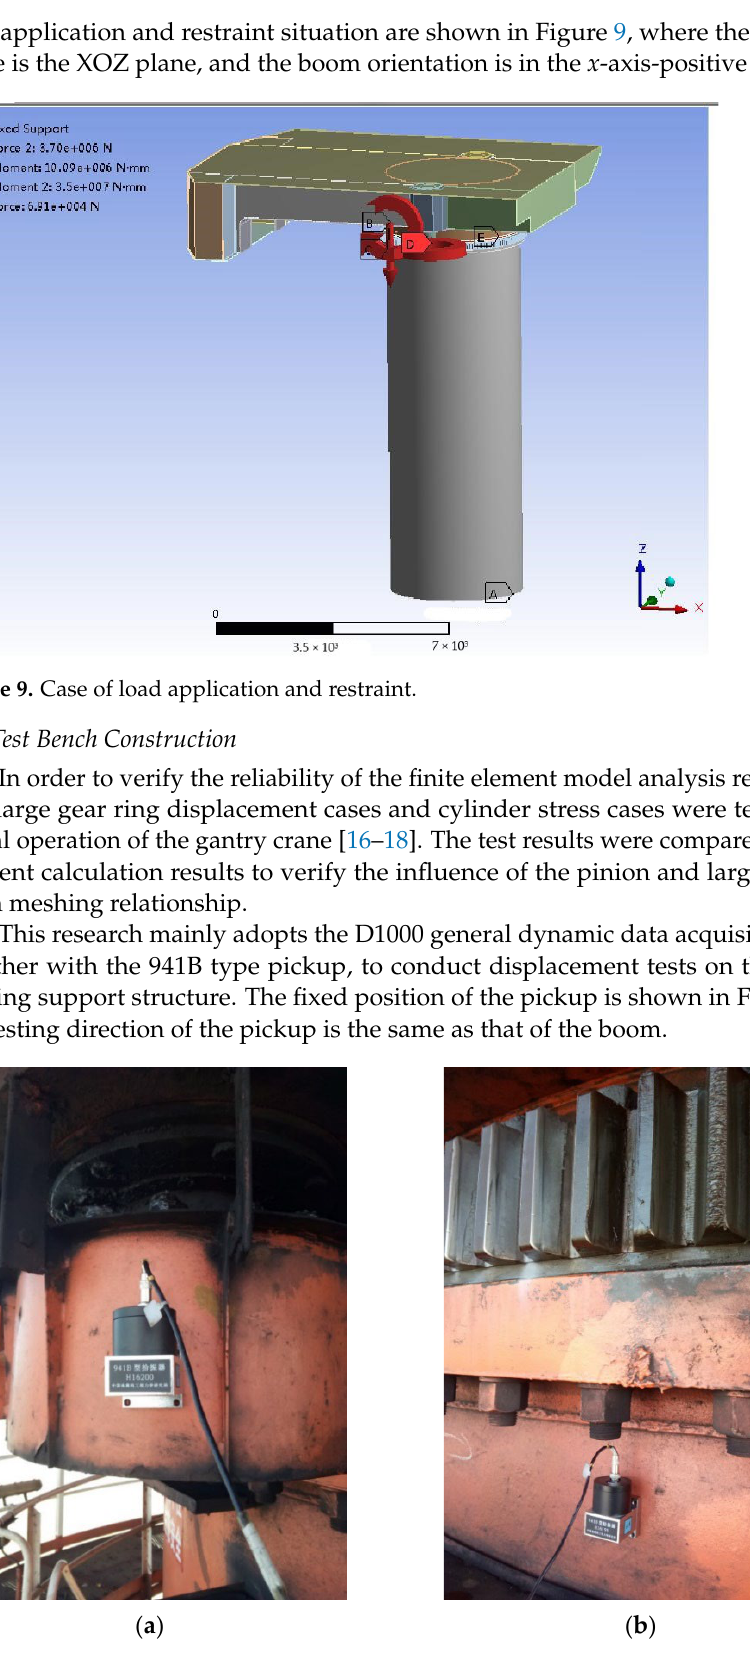
Figure 10. Position of vibration pickup for ring displacement test : ( a ) Pinion; ( b ) large gear ring.